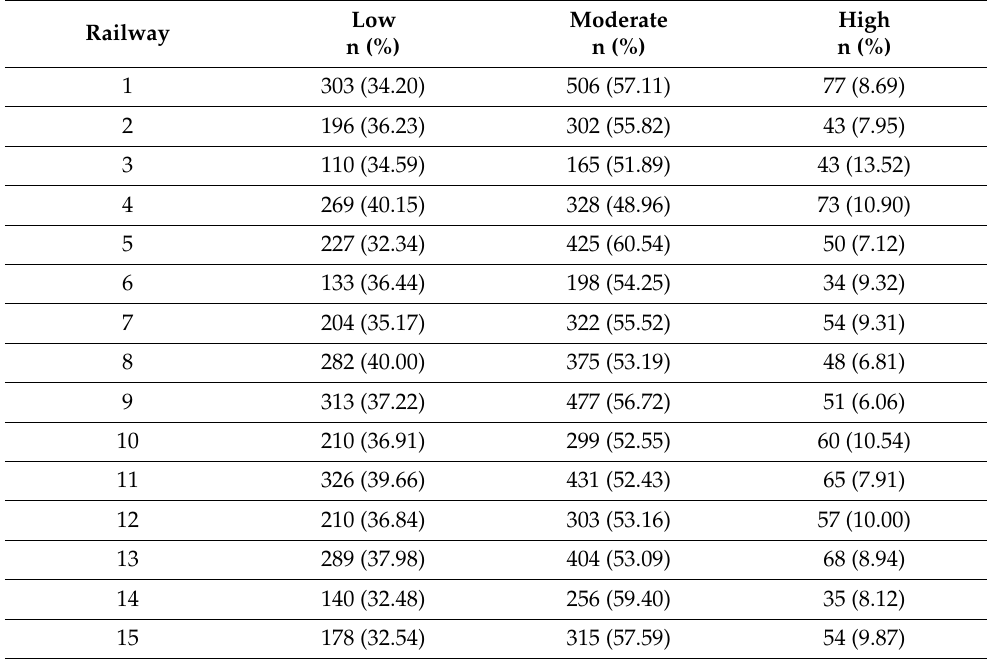
Table 5. Level of commitment to a healthy lifestyle by railway.